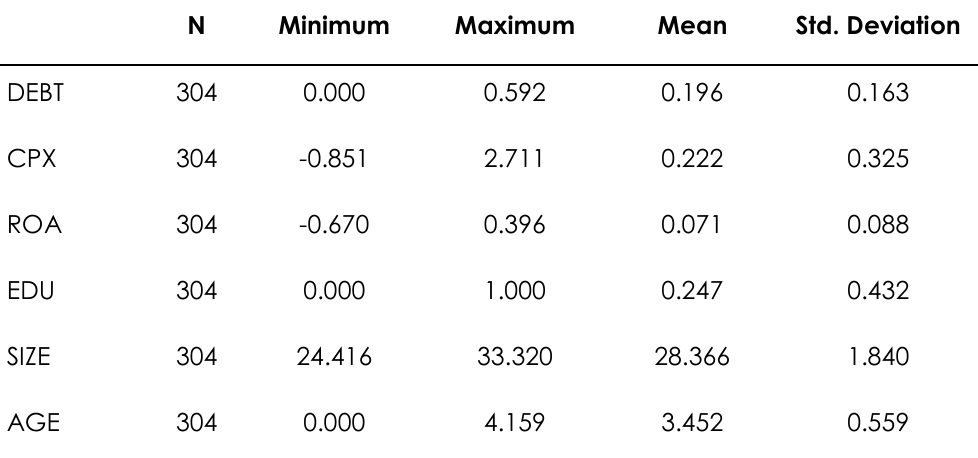
N Minimum Maximum Mean Std.